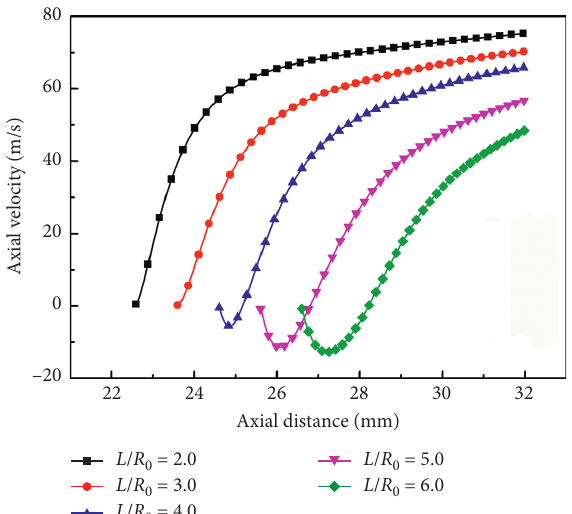
Figure 9: The axial velocity distribution along the centerline of the valve spool with different length/diameter ratios.